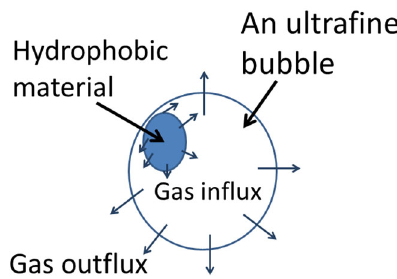
Figure 1. Dynamic equilibrium model of an ultrafine bubble (bulk nanobubble) partly covered with hydrophobic material (impurity). Reprinted with permission from Ref. [56]. Copyright 2016, the American Chemical Society.